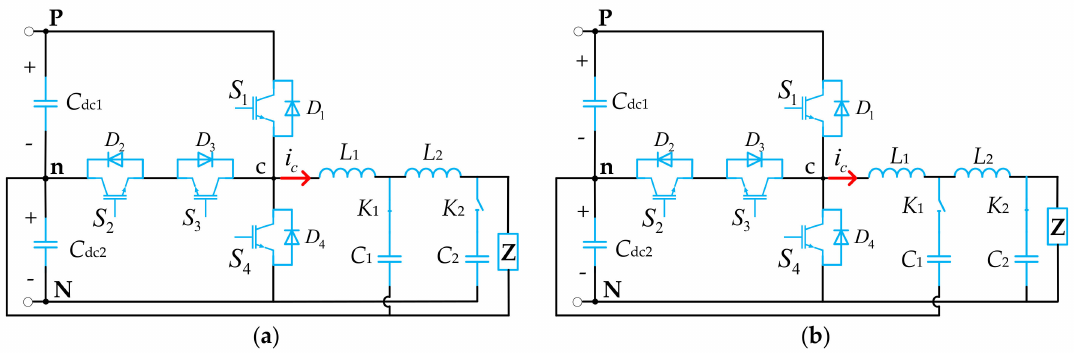
Figure 2. T-type three-level converter under. ( a ) AC mode; ( b ) DC